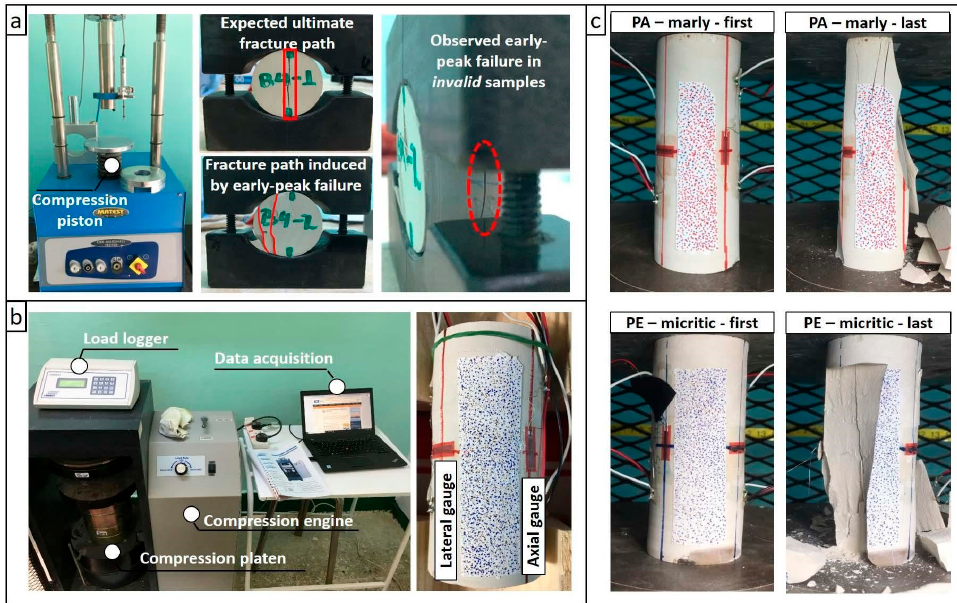
Figure 4. Mechanical tests to measure strength of rock samples, with pictures showing the ( a ) appa- ratus for BTS tests and curved Brazilian loading jaw with BTS samples shown after peak strength is achieved and the fracture path connecting the two bearing points, and another type of failure influenced by the existence of planes parallel to the disc face (invalid sample). ( b ) Apparatus and an example specimen used in the UCS test with installed lateral and axial strain gauges on the sample surface, as well as ( c ) UCS tests of PA and PE samples with pictures of initial state (left) and at peak strength